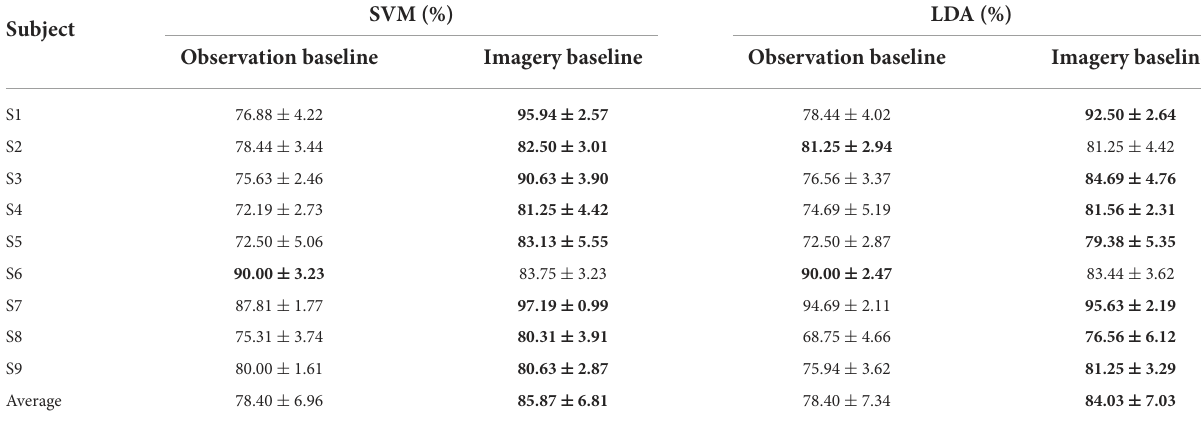
TABLE 6 The multi-channel clustered feature calculation based on different baseline time in griping vs. opening classification.